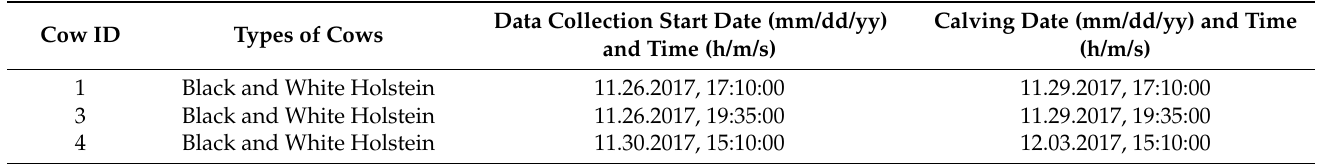
Table 1. Group 1: Primiparous pregnant cows data information.